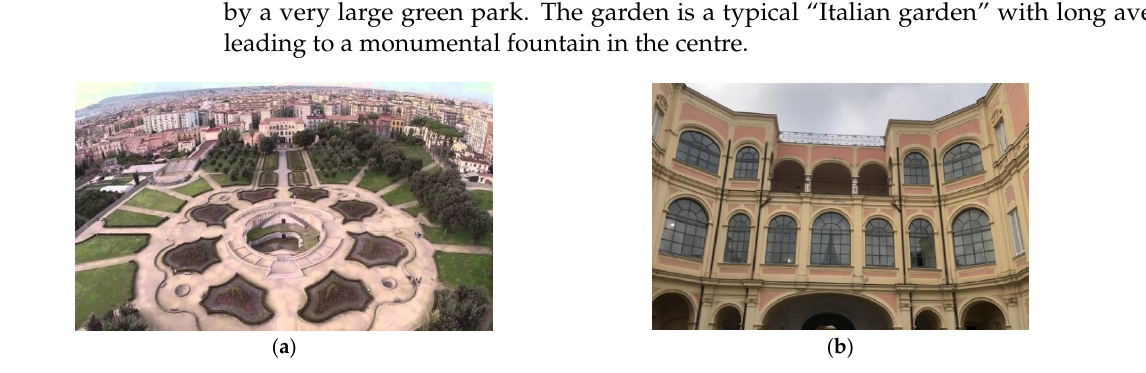
Figure 2. ( a , b )–Villa Vannucchi, San Giorgio a Cremano. ( a ) The park of Villa Vannucchi, www.wikipedia.org (accessed on 5 May 2022); ( b ) The internal façade of Villa Vannucchi.